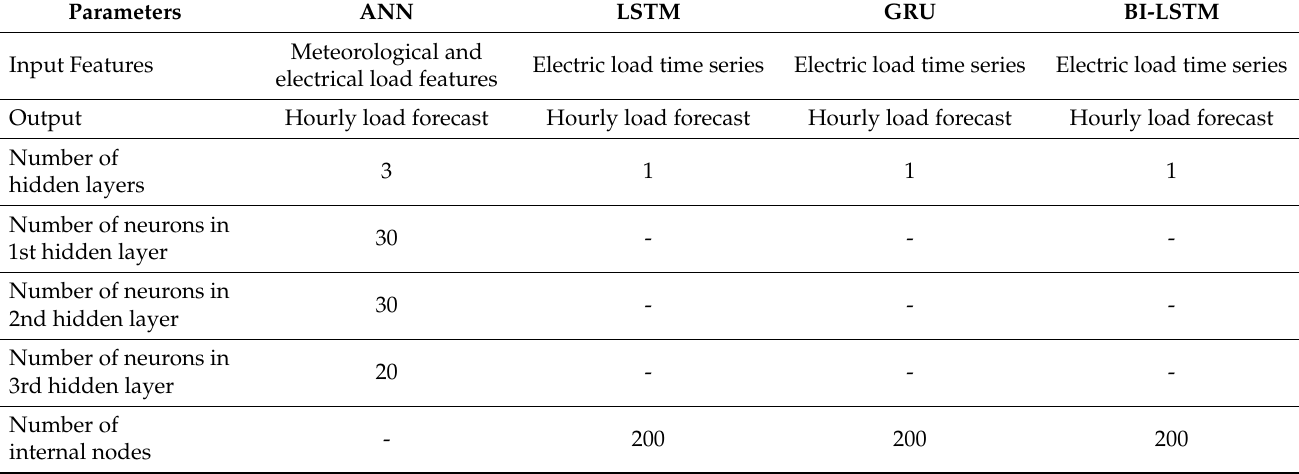
Table 2. Parameters for ANN, LSTM, GRU and Bi-LSTM